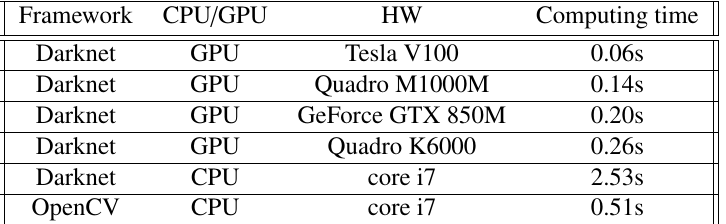
Table 1. Computing time of YOLOv3 in various hardware scenarios in Darknet and